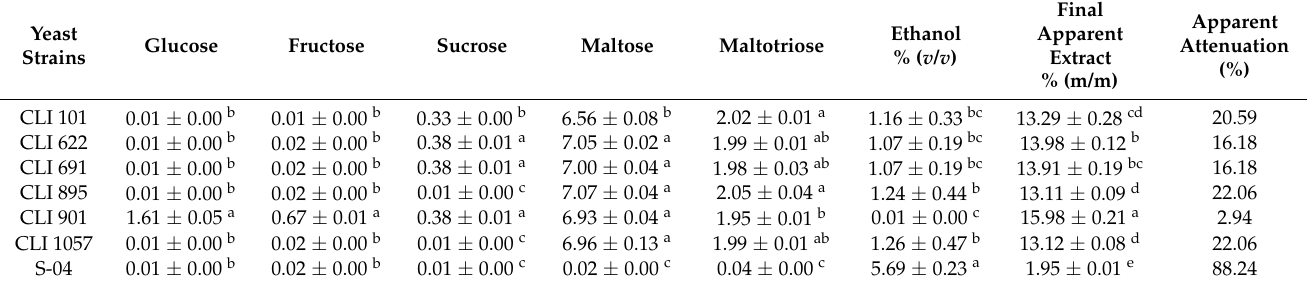
Table 1. Residual sugars (g/100 mL) and ethanol content in beers obtained after fermentation with six non-conventional yeast and the control S-04 strain in trials with 400 mL of